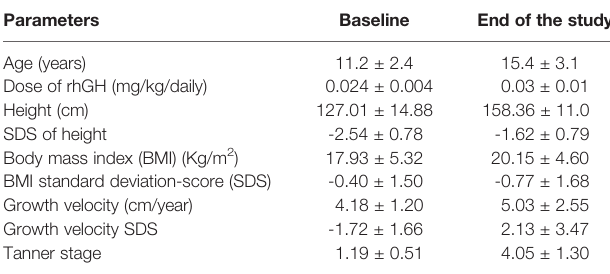
TABLE 1 | Anthropometric and auxological characteristics of the 93 patients with growth hormone (GH) de fi ciency included in this study at baseline [before the start of recombinant human GH (rhGH) therapy] and at the end of the study.